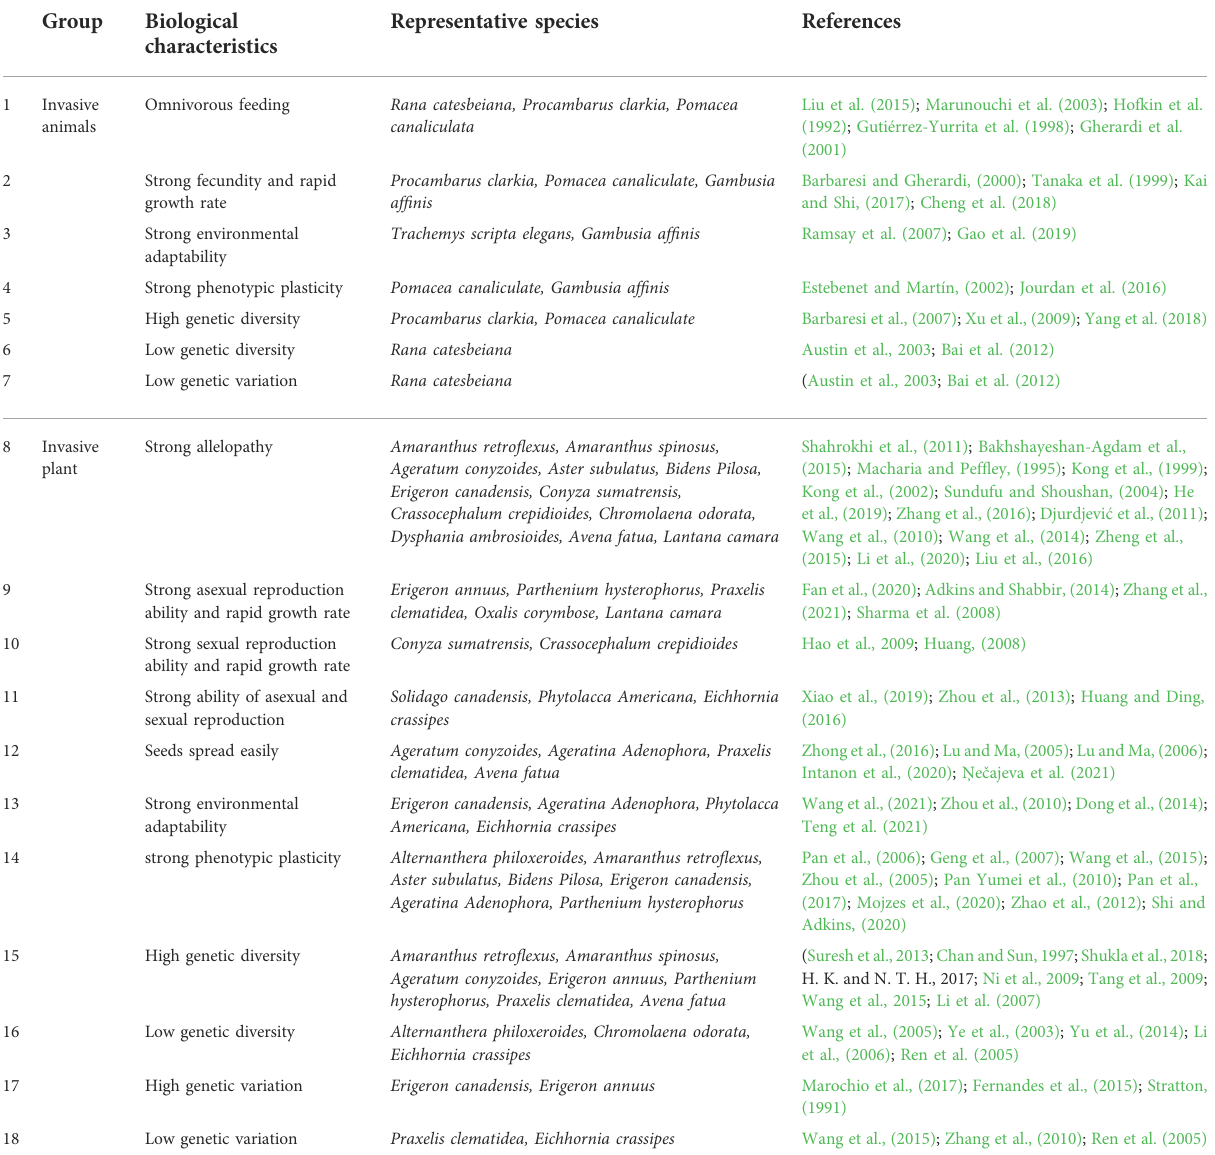
TABLE 1 Main biological characteristics of invasive alien species in Karst areas of Southwest